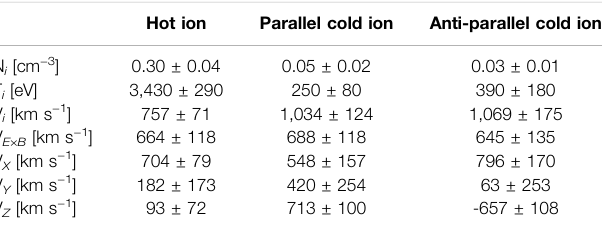
TABLE 1 | Average partial moments of the hot and cold ions of the selected data points shown in Figure 5 Hot ion Parallel cold